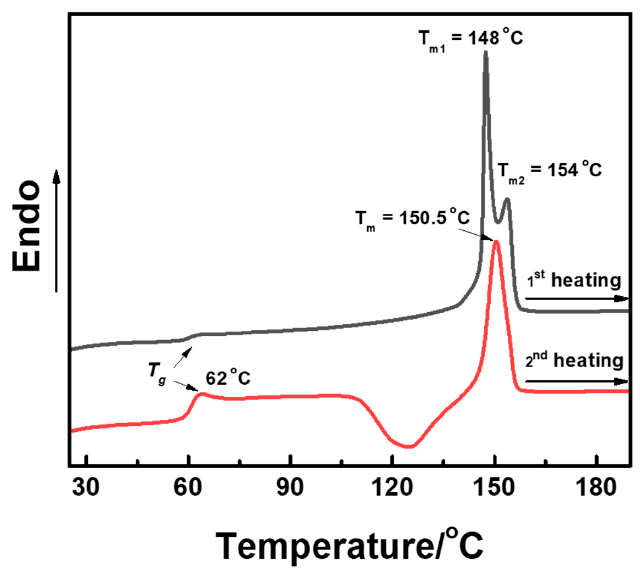
Figure 6. The DSC heating curves of oriented PLLA film friction transferred at 100 °C recorded in the first and second runs with heating rate of 10 °C/min.